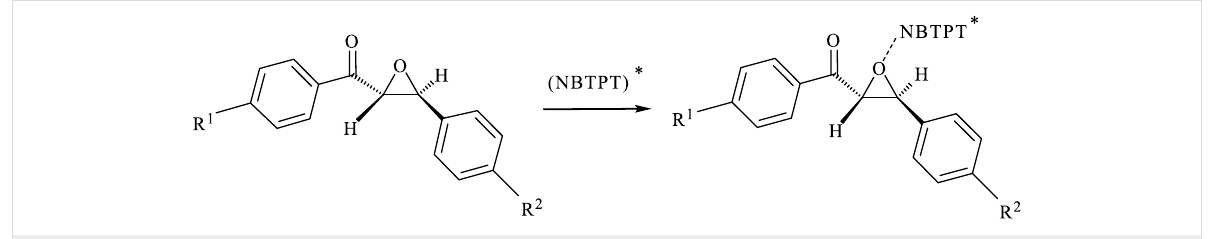
Scheme 3: Possible formation of a complex involved in reaction in acetone.